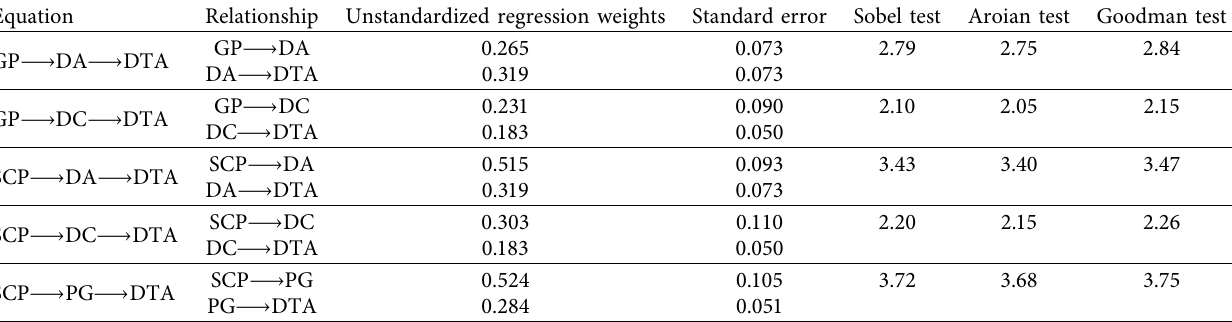
Table 5: Mediating effect